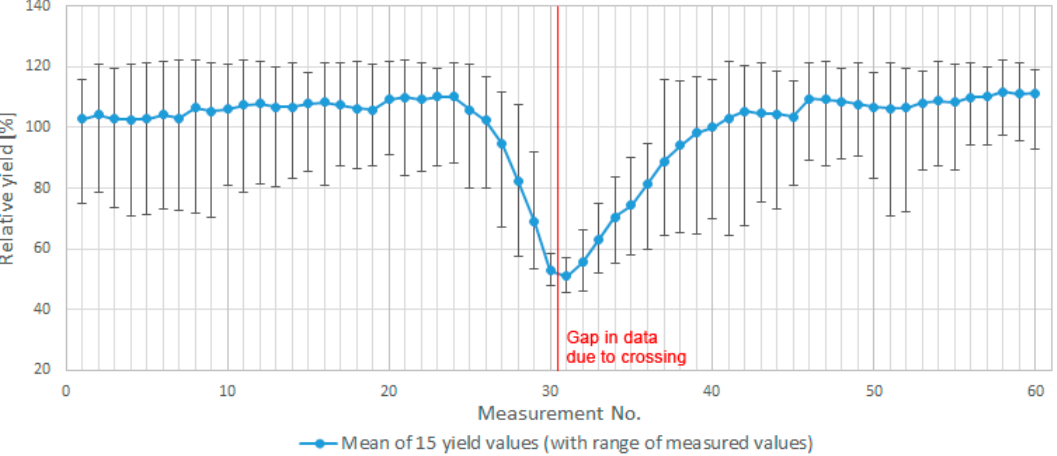
Figure 3. The mean and the range of yield values in crossings of a farm machinery trajectory: a demonstration of point measurements for a proof-of-concept uncertainty definition.